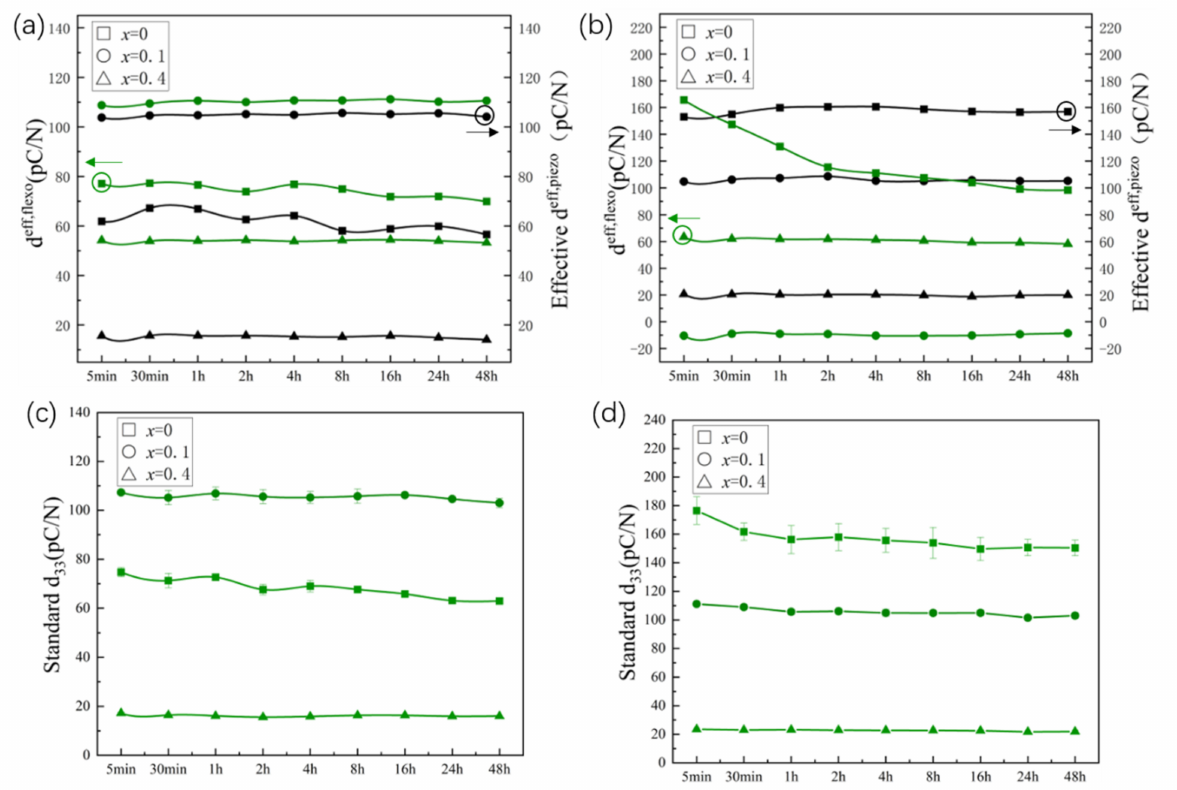
Figure 6. Time dependence of d eff,flexo and d eff,piezo of Ba 1 − x Ca x TiO 3 ( x = 0, 0.1, 0.4) ceramics after ( a ) 400 V and ( b ) 800 V polarization. Time dependence of standard piezoelectric coefficient d 33 of Ba 1 − x Ca x TiO 3 ( x = 0, 0.1, 0.4) ceramics after ( c ) 400 V and ( d ) 800 V